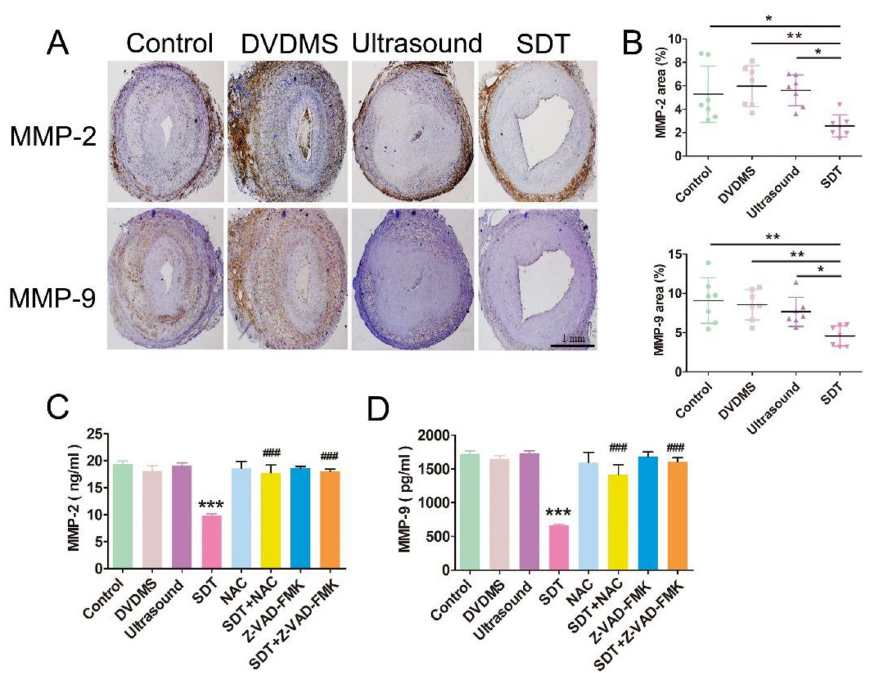
Fig 3. Sinoporphyrin sodium-mediated sonodynamic therapy (DVDMS-SDT) reduces the production of MMP-2 and MMP-9 in rabbit atherosclerotic plaque macrophages. DVDMS-SDT reduced the expression of MMP-2 and MMP-9 in the rabbit plaque at 1 month after treatment. (A) Representative histopathological staining of consecutive plaque sections and (B) represents quantification (n = 7). THP-1-derived foam cells were pre-treated with N-acetyl-L- cysteine (NAC) or Z-VAD-FMK for 1 h, followed by DVDMS-SDT treatment. At 6 h after treatment, the supernatants in the indicated groups were collected for determination of the concentration of MMP-2 (C) and MMP-9 (D) by enzyme-linked immunosorbent assay (ELISA). Data on graph were representative of three independent experiments (n = 8). NAC = N-acetyl- L-cysteine. Z-VAD-FMK = methyl (3S)-5-fluoro-3-[[(2S)-2-[[(2S)-3-methyl2 (phenylmethoxycarbonlam ino)butanoyl] ami-no]propanoyl] amino]-4-oxopentanoate. � P < 0.05, �� P < 0.01, ��� P < 0.001 vs. control, ### P < 0.001 vs. SDT.